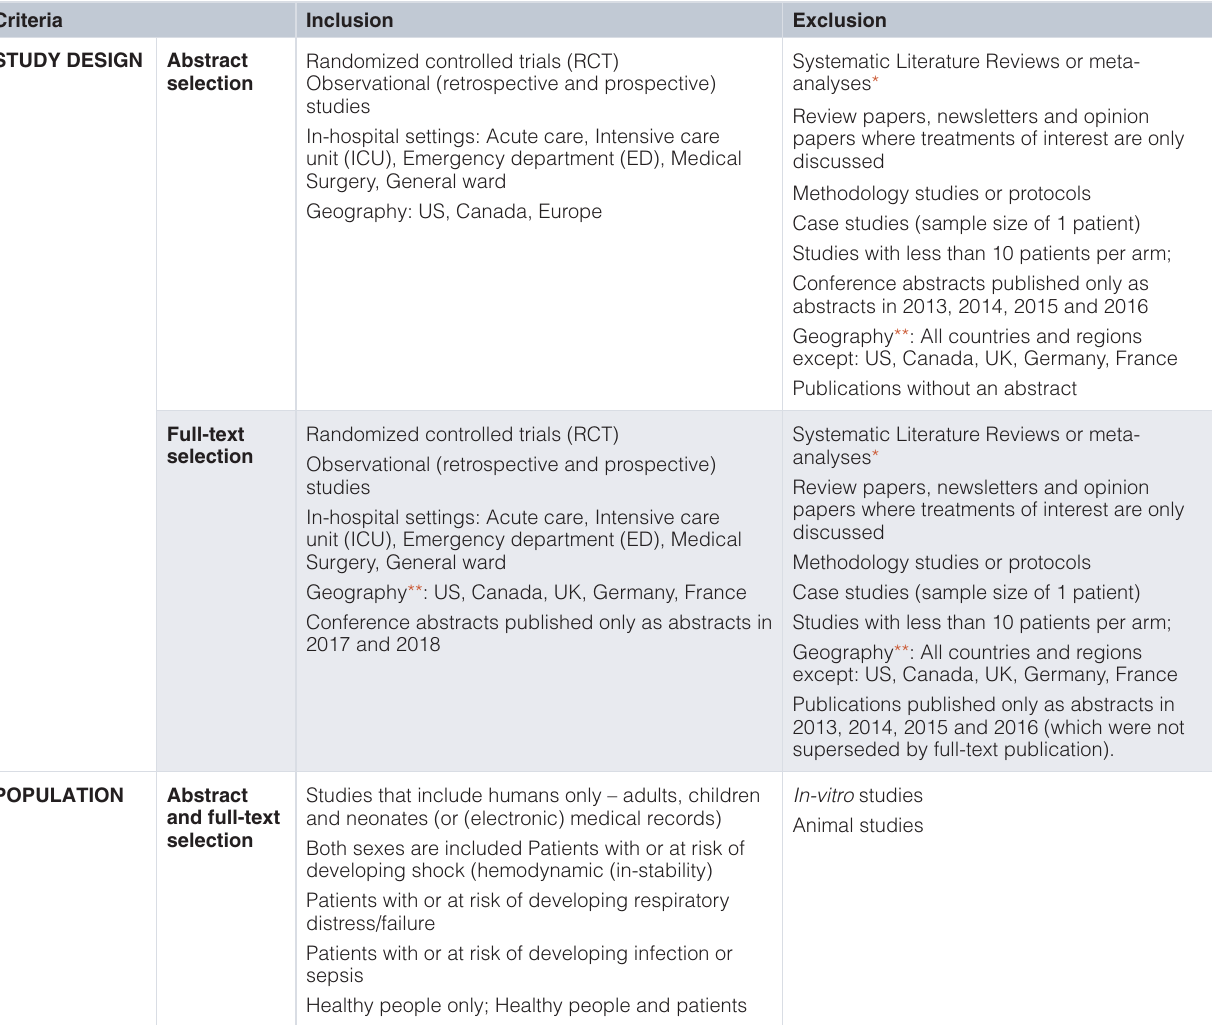
Table 1. Study selection criteria for the systematic literature review.